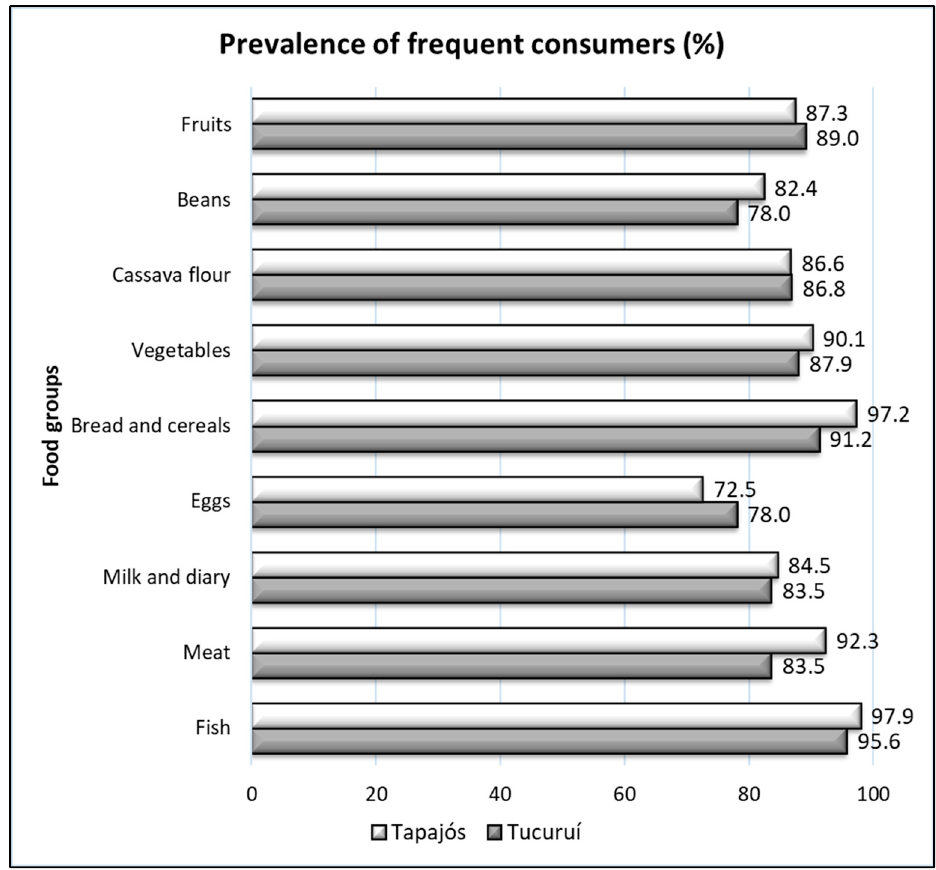
Figure 4. The prevalence of consumers (three or more times a week) of different food groups in the Tapajós (n = 143) and Tucuruí (n = 91) regions.